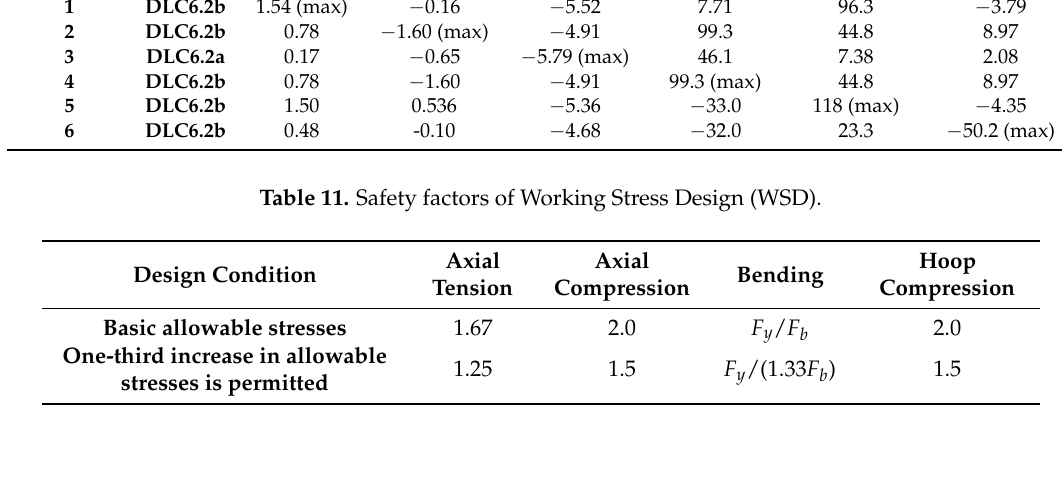
Table 10. Loading of Force (F n ) and Moment (M n ) at Tower Top due to OWTG Dynamics Case No.